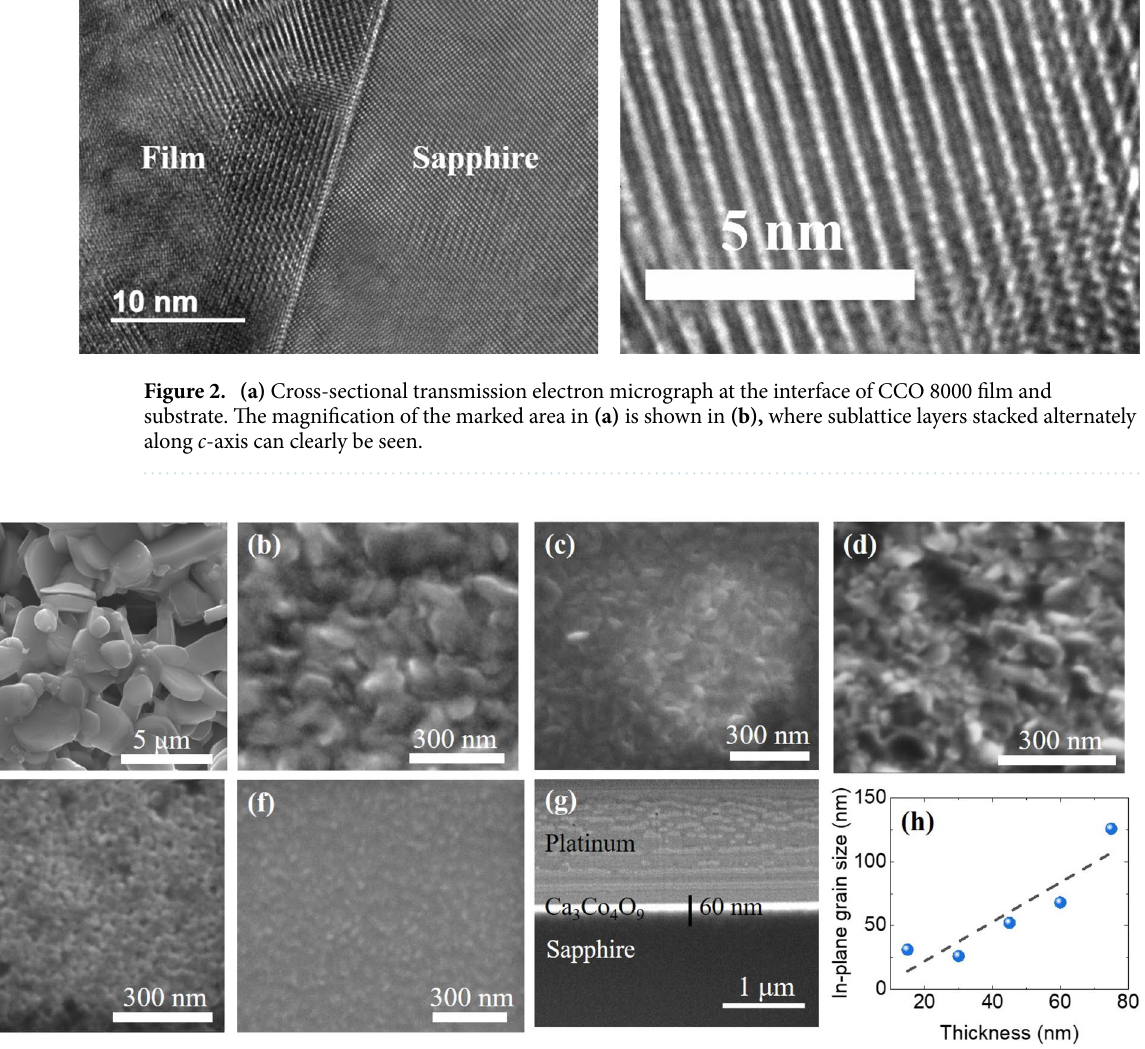
Figure 3. The top-view SEM images of (a) bulk Ca 3 Co 4 O 9 and thin films with thickness of (b) 75 nm, (c) 60 nm, (d) 45 nm, (e) 30 nm and (f) 15 nm. The cross-section SEM of interfacial region (g) the thickness of Ca 3 Co 4 O 9 films prepared with 8000 laser shots is around 60 nm. (h) Variation of in-plane grain sizes in various CCO films as a function of